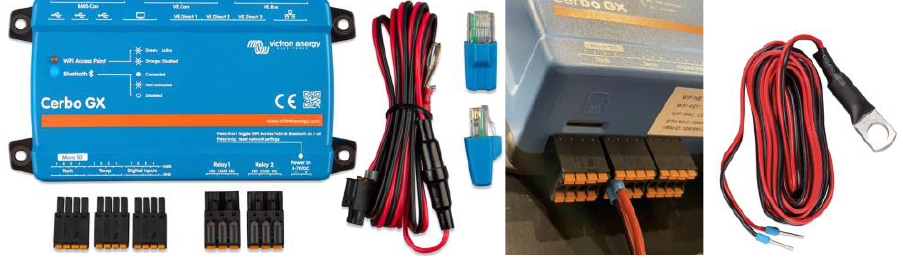
Figure 13. Cerbo GX, temperature sensor inputs, and relay output.